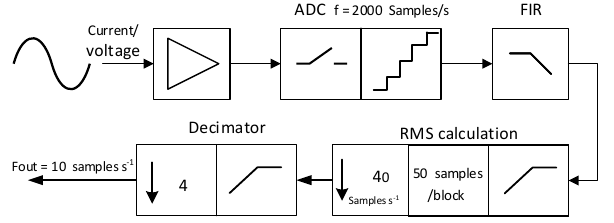
Figure 8. Measurement chain of the effective current and voltage.